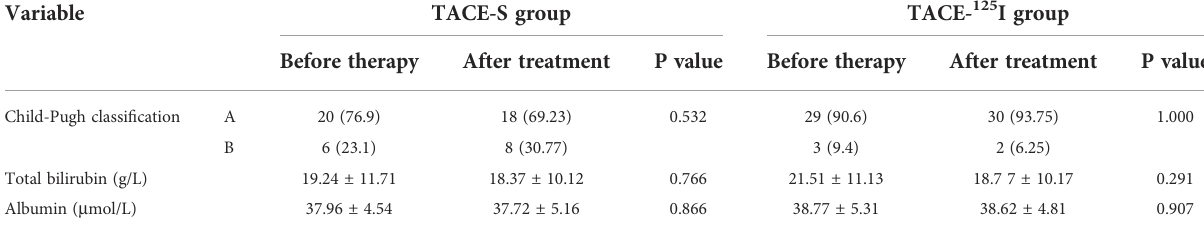
TABLE 3 Comparison of Child-Pugh classi fi cation, as well as total bilirubin and albumin levels, before treatment and 3 months after treatment in the TACE- 125 I group and the TACE-S group.